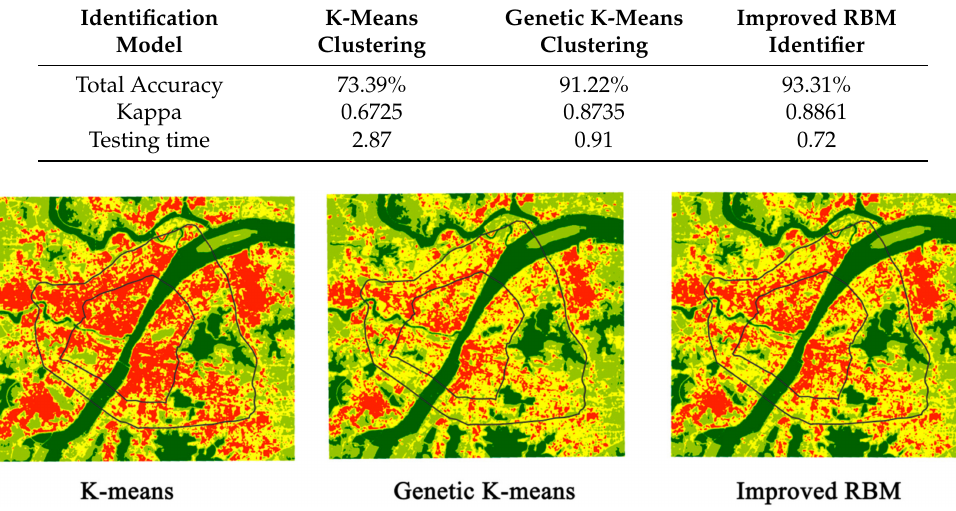
Figure 7. Comparison of identification results obtained by different